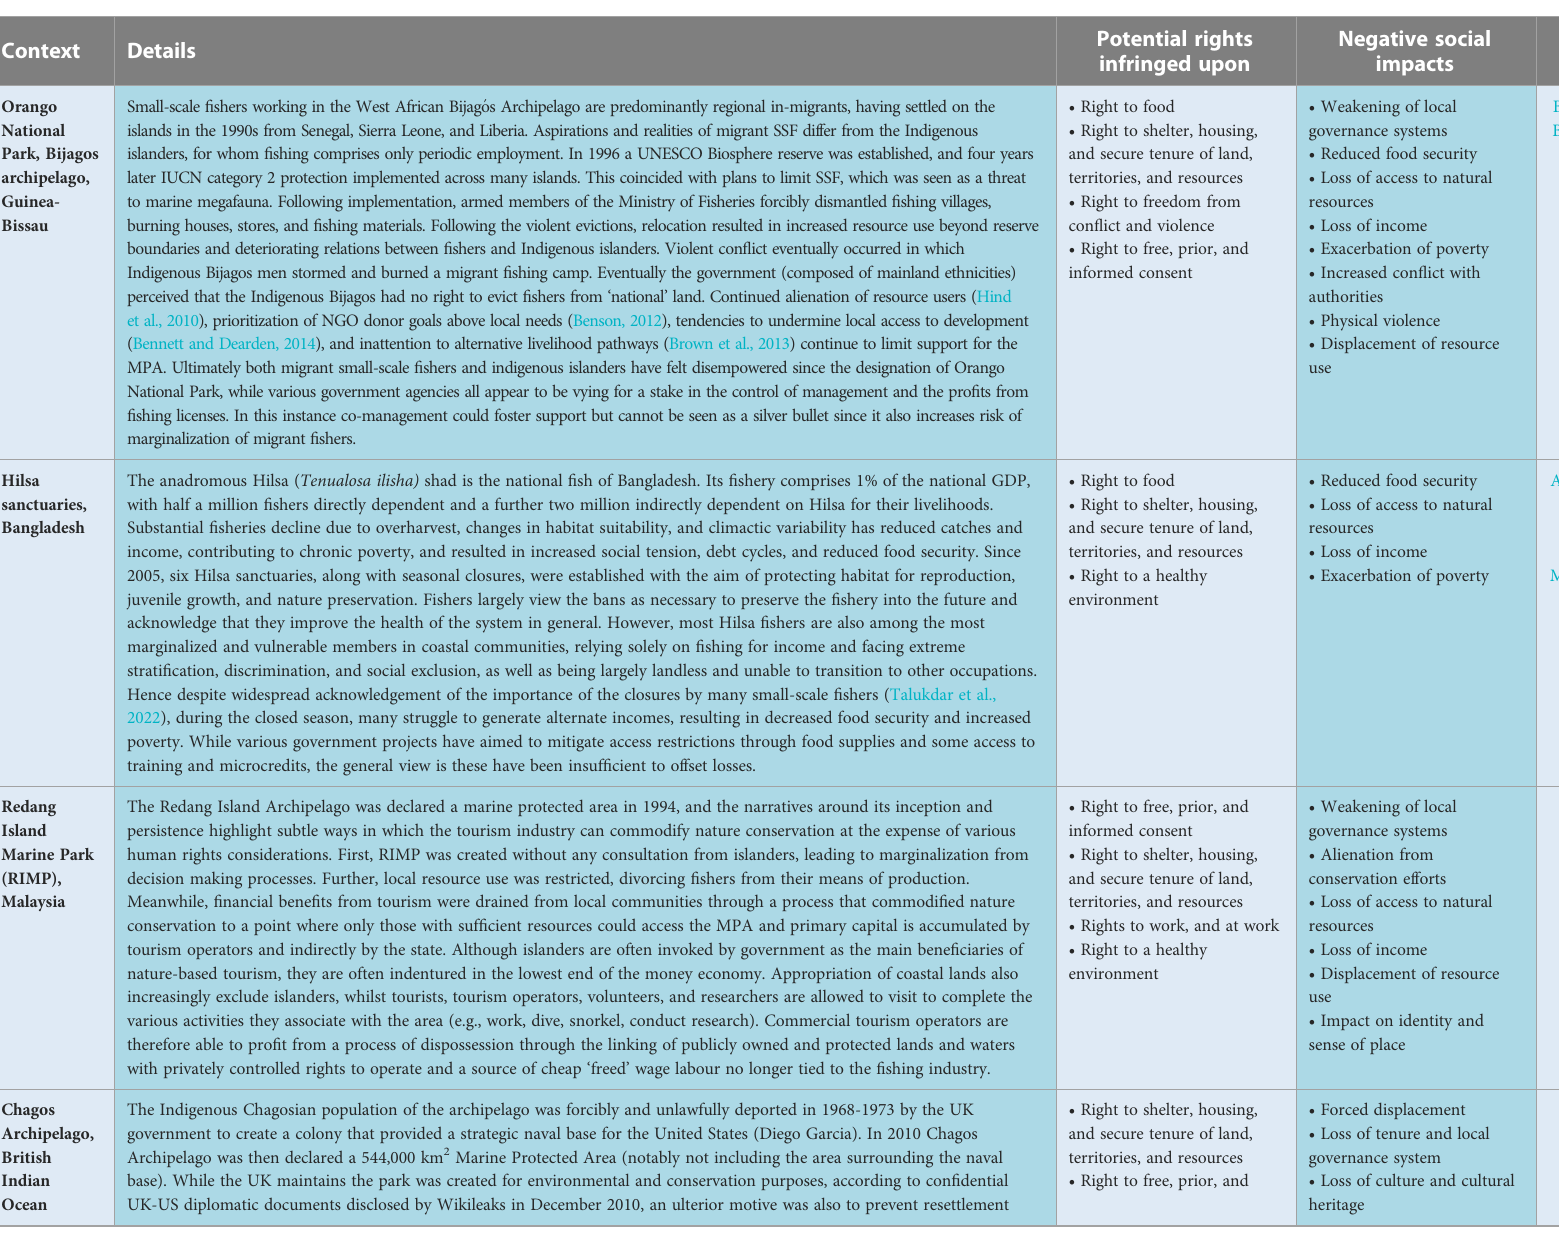
TABLE 3 Examples of tensions between marine conservation and human rights, with focus on small-scale fi sheries and marine protected